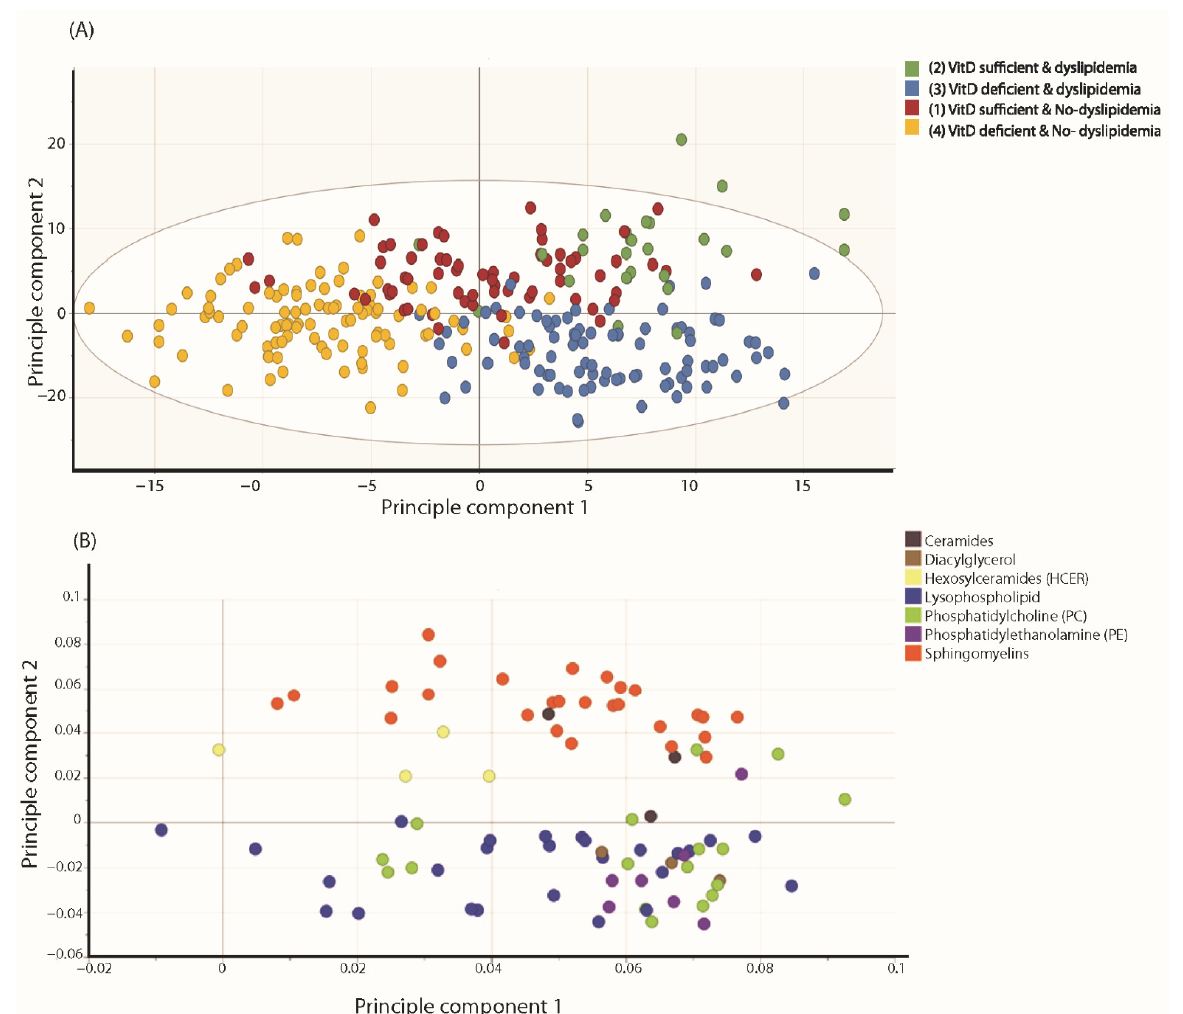
Figure 2. Illustration of OPLS-DA analysis for the four groups. ( A ): represents a scatter plot of two principal components, distinguishing all four groups in a two-dimensional space. ( B ): represents a loading plot highlighting the weights of the metabolites in all four groups, indicating top metabolite responsible for group separation. R2Y (cum) was 0.637, and Q2 (cum) was 0.229. Vitamin D sufficient and normolipidemic (Group 1, n = 64); Vitamin D sufficient and dyslipidemia (Group 2, n = 26); Vitamin D deficient and dyslipidemia (Group 3, n = 88); Vitamin D deficient and normolipidemic (Group 4, n = 99).